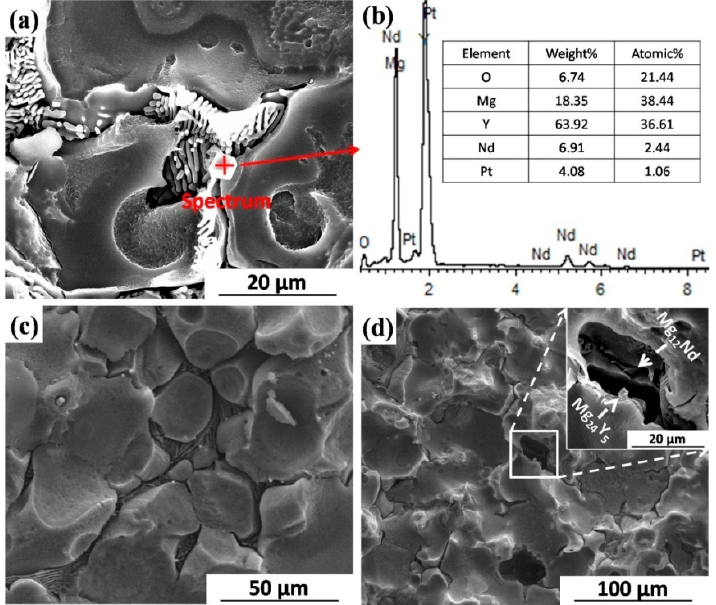
Figure 15. Surface morphologies of BM specimens after different immersion time intervals in SBF and the corresponding EDS spot analysis: ( a , b ) 3 h; ( c ) 6 h; and ( d ) 12 h (without corrosion products).